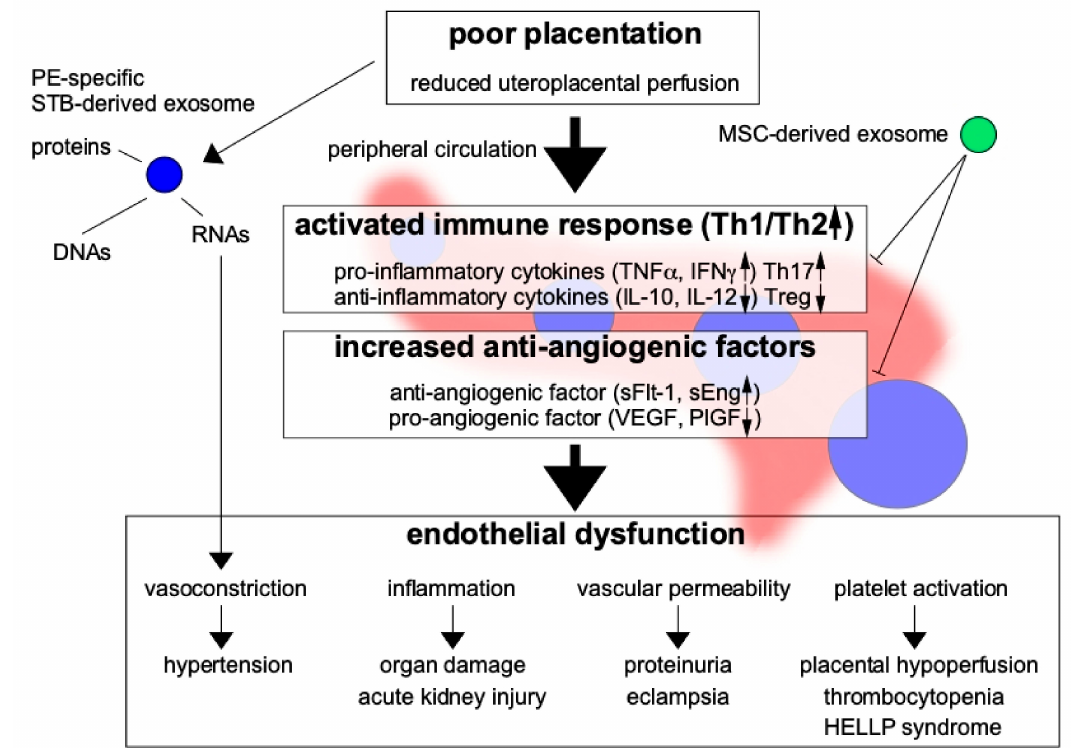
Figure 2. Poor placentation secrets exosomes and promotes immune reactivity and anti-angiogenic factors resulted in increased proinflammatory cytokines and anti-angiogenic factors. On the other hand, anti-inflammatory cytokines and pro-angiogenic factors are decreased. Preeclampsia (PE)-specific exosomes derived from damaged trophoblasts are secreted and may transport RNA, DNA, and proteins to distant maternal organs, causing multiple-organ failure, especially due to endothelial dysfunction. The pathogenesis of PE may be ameliorated by the immunosuppressive and anti-inflammatory effects of mesenchymal stem cell (MSC)-derived exosomes. Th17: type-17 T helper cell, Treg: regulatory T cell, VEGF: vascular endothelial growth factor, PlGF: placental growth factor. Blue circle: pathogenic exosomes, Green circle: exosomes with therapeutic